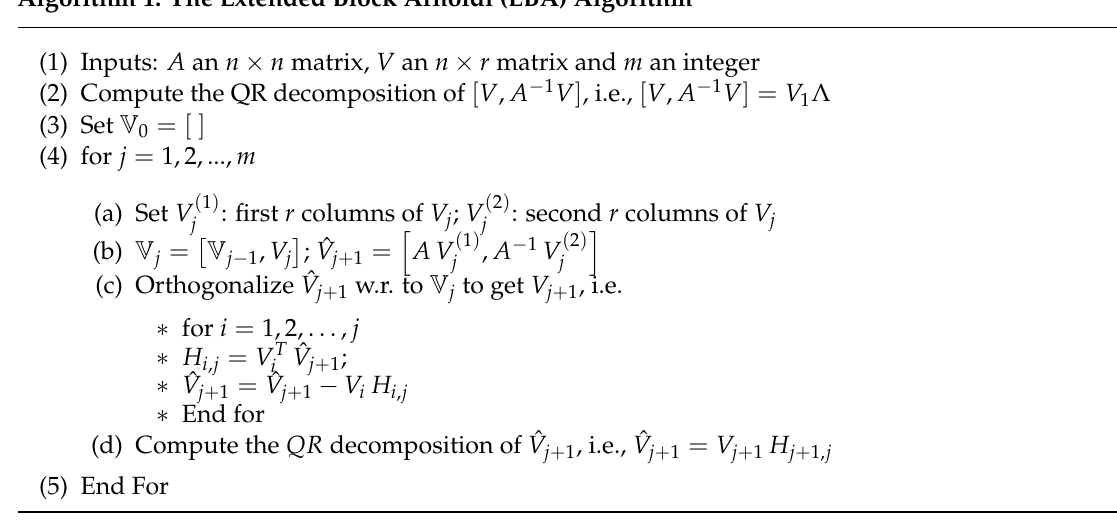
Algorithm 1. The Extended Block Arnoldi (EBA)